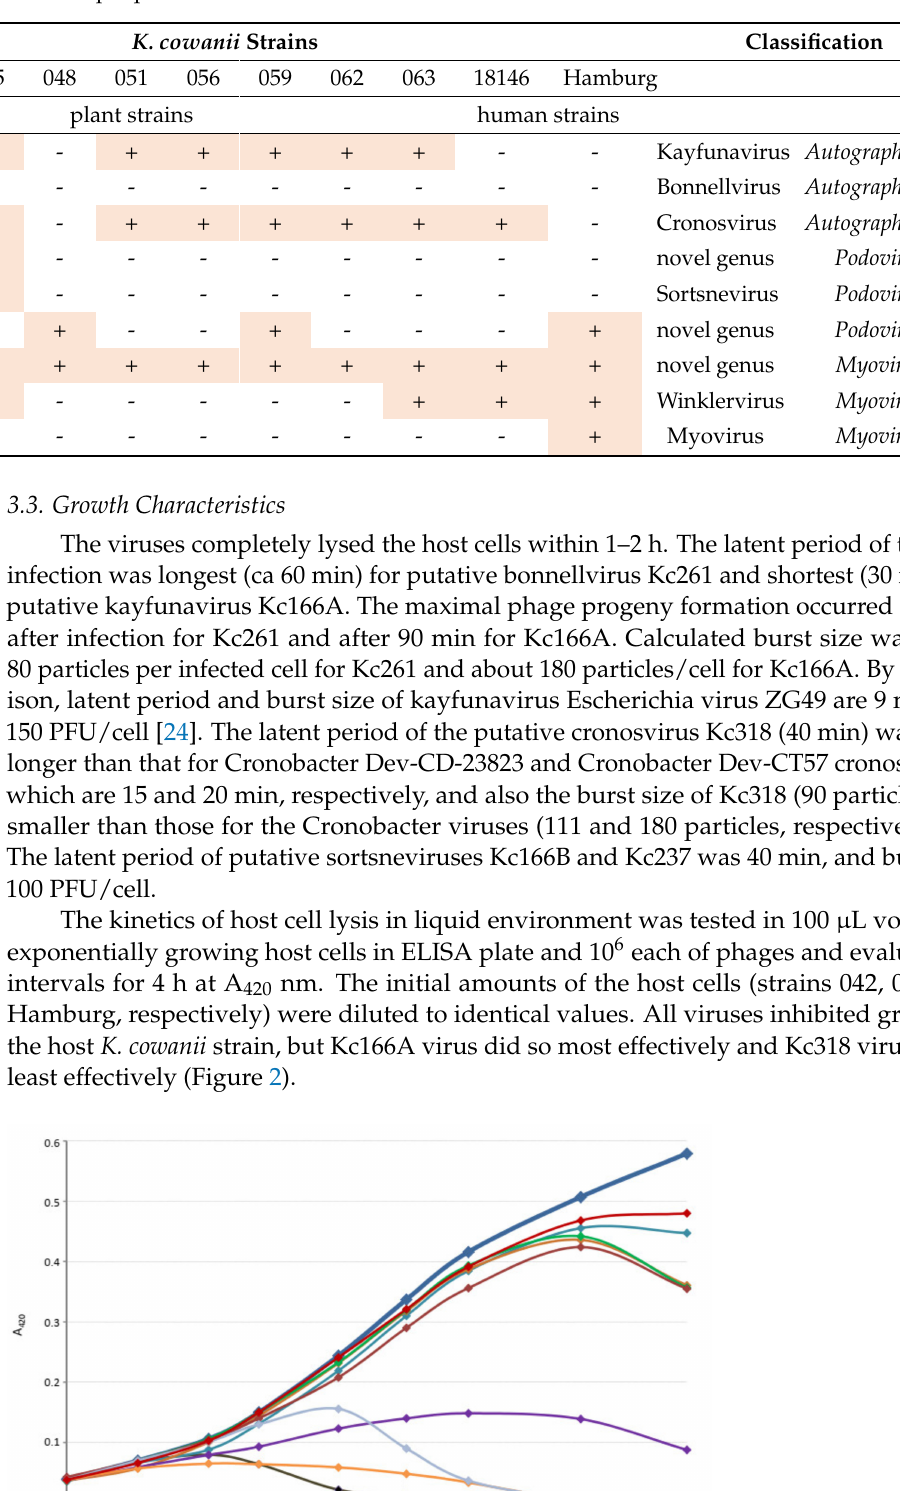
Table 1. Host specificity of Kosakonia viruses was tested on nine plant isolates and two human isolates of K. cowanii . Plaque formation is marked “+”, absence of plaque is marked “-“.